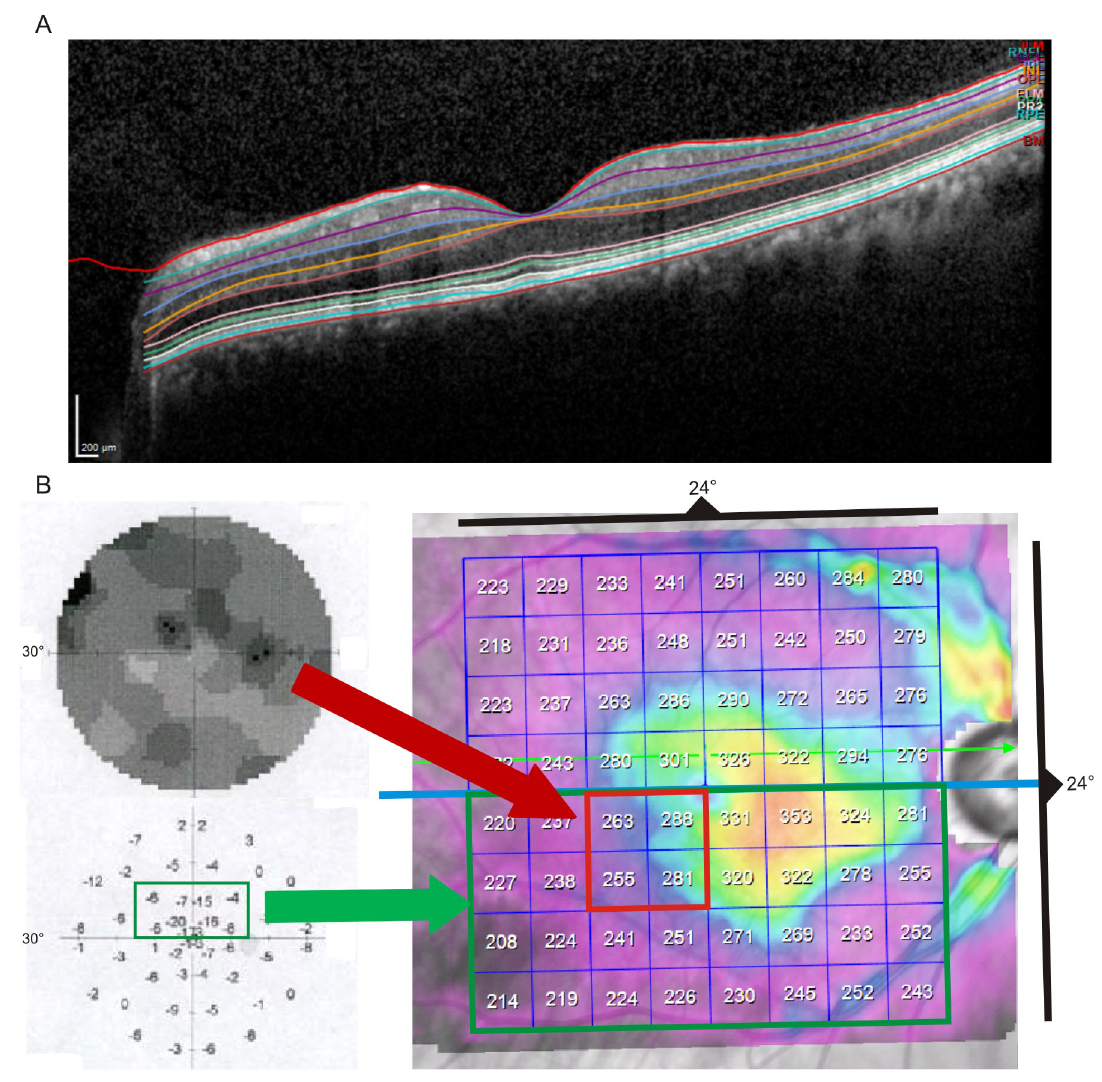
Fig 2. Locations and layering of analyses. A) Single SD-OCT scan in the macular region including foveola and optic nerve head. The automated retinal layer segmentation is outlined in different colors. B) Schematic description of proceeding during hemifield analysis. 30˚ static automatic perimetry map with an absolute visual field scotoma in the central 10˚ (red dotted box). The arrays in the SD-OCT- map corresponding to the scotoma are outlined in the 8 x 8 map of the macula. The green dotted box indicates the corresponding visual field sectors with arrays of the inferior hemifields of the SD-OCT